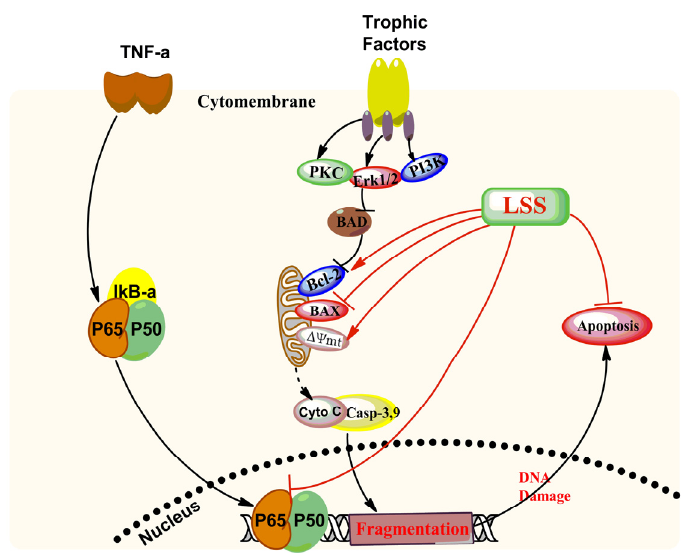
Figure 8. Proposed scheme of possible mechanisms for LSS inhibition of apoptosis induced by A β 25-35 through regulation of the apoptotic and NF- κ B pathways in PC12 cells.